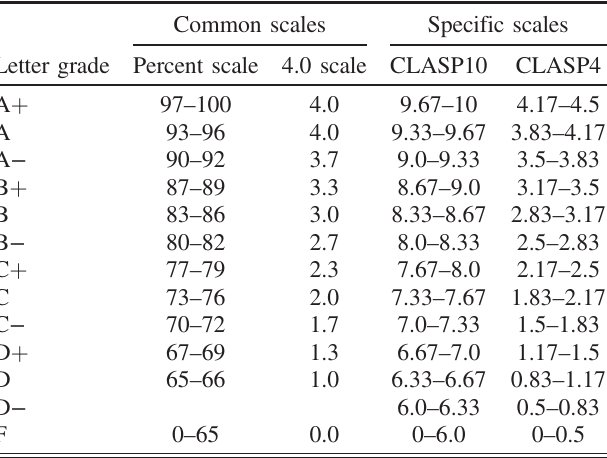
percent scale and 4.0 scale conversions are from the College Board website. CLASP10 is the specific version of the percent scale whose results are discussed in the paper and CLASP4 is the specific 4-point scale